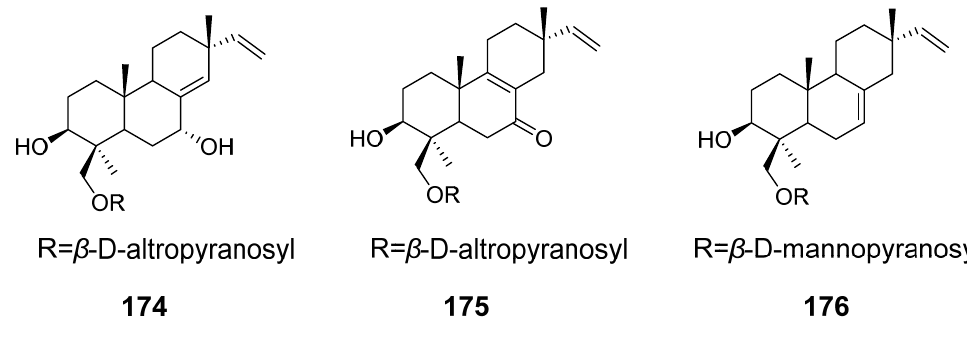
Figure 17. Structures of compounds 174 – 176 .